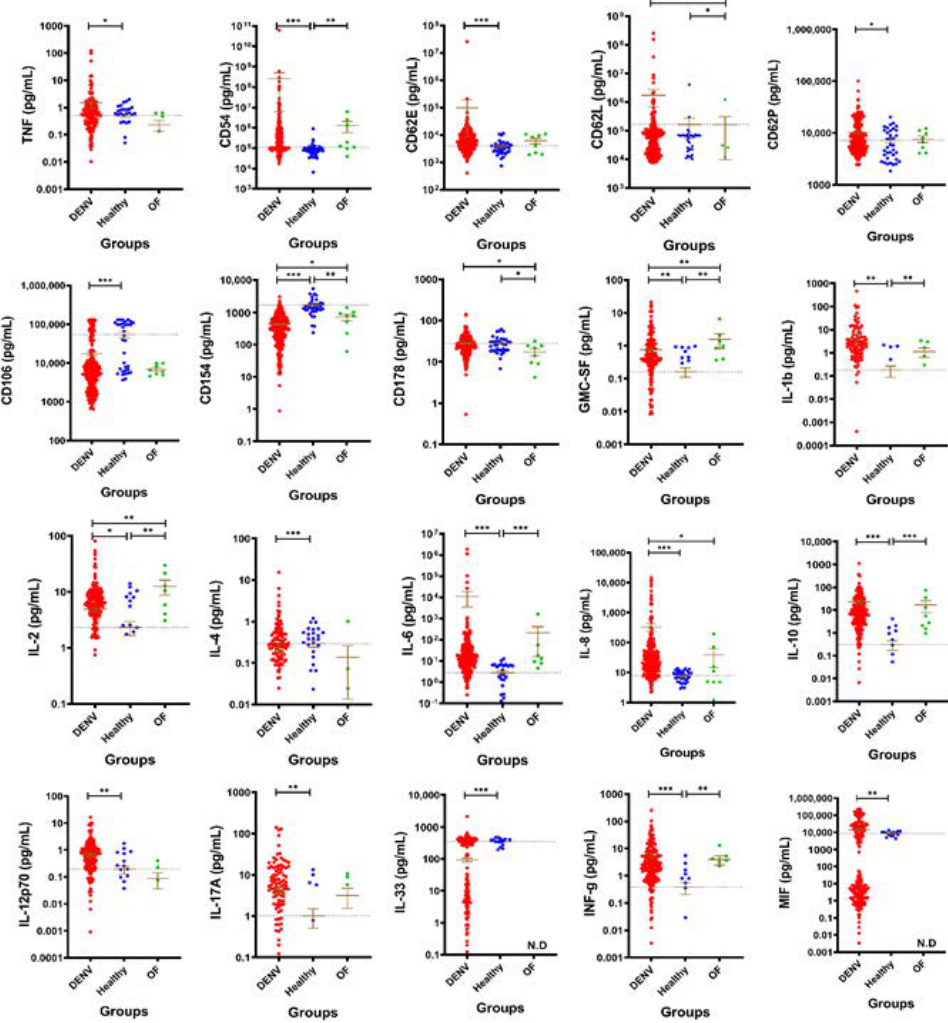
Figure 1. The levels of cytokines in DENV patients. Patients were divided into three groups: Laboratory confirmed DENV-2 patients (DENV), laboratory confirmed DENV negative (OF) and healthy volunteers (Healthy). Only cytokines having a significance difference between either DENV, Healthy or OF were shown here. Cytokines with no significance difference can be found in Supplementary Figure S1. Mean ± SEM. Horizontal dotted line represents health mean average. N.D (no data). p < 0.05 *; p < 0.01 **; p < 0.001